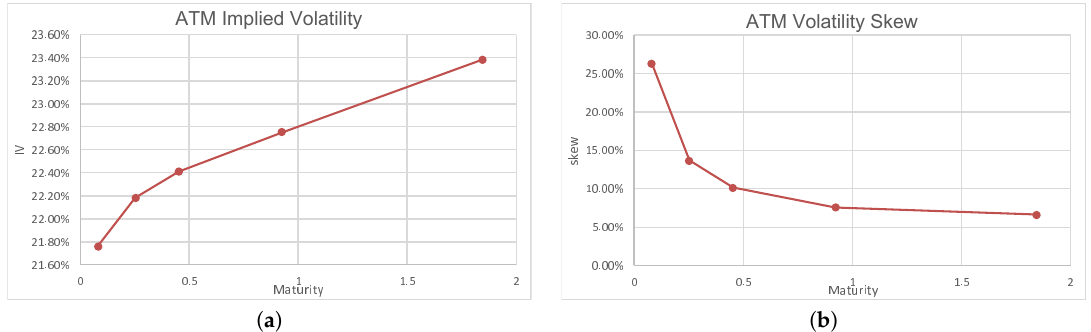
Figure 1. ATM implied volatility ( a ) and ATM skew ( b ) with respect to the option maturity. The model parameters are listed in Table 1.